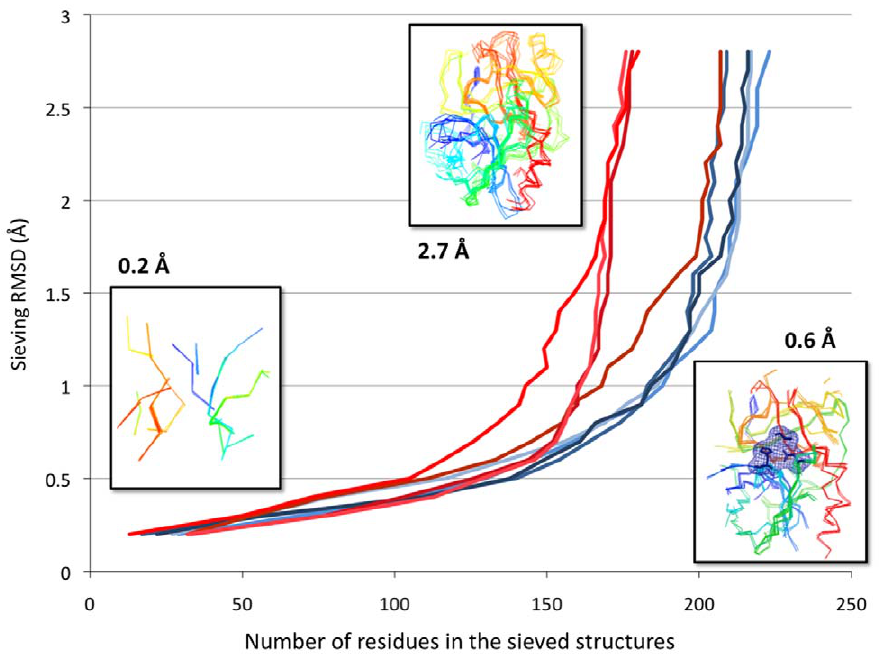
Figure 3. Plot of number of residue correspondences vs. RMSD in each structure. Eukaryotic proteases (3EST, 1TON, 3RP2, 5CHA) are in blue, prokaryotic (1SGT, 2SGA, 3SGB, 2ALP) in red. The boxes highlight superpositions of sieved structures with their corresponding RMSD. At 0.6 A˚, the catalytic triad and its wireframe surface are displayed in dark blue.